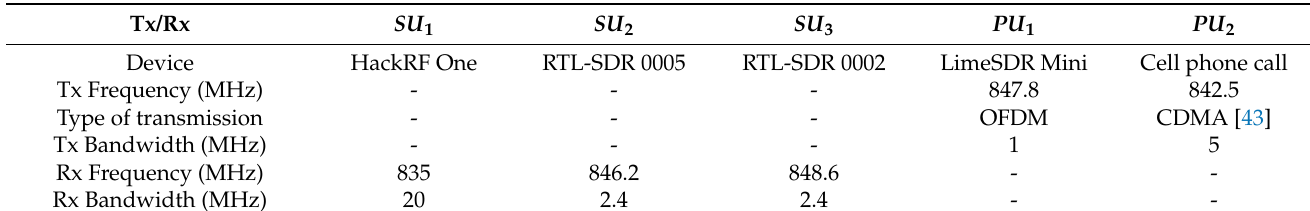
Table 2. Parameters of the considered devices.